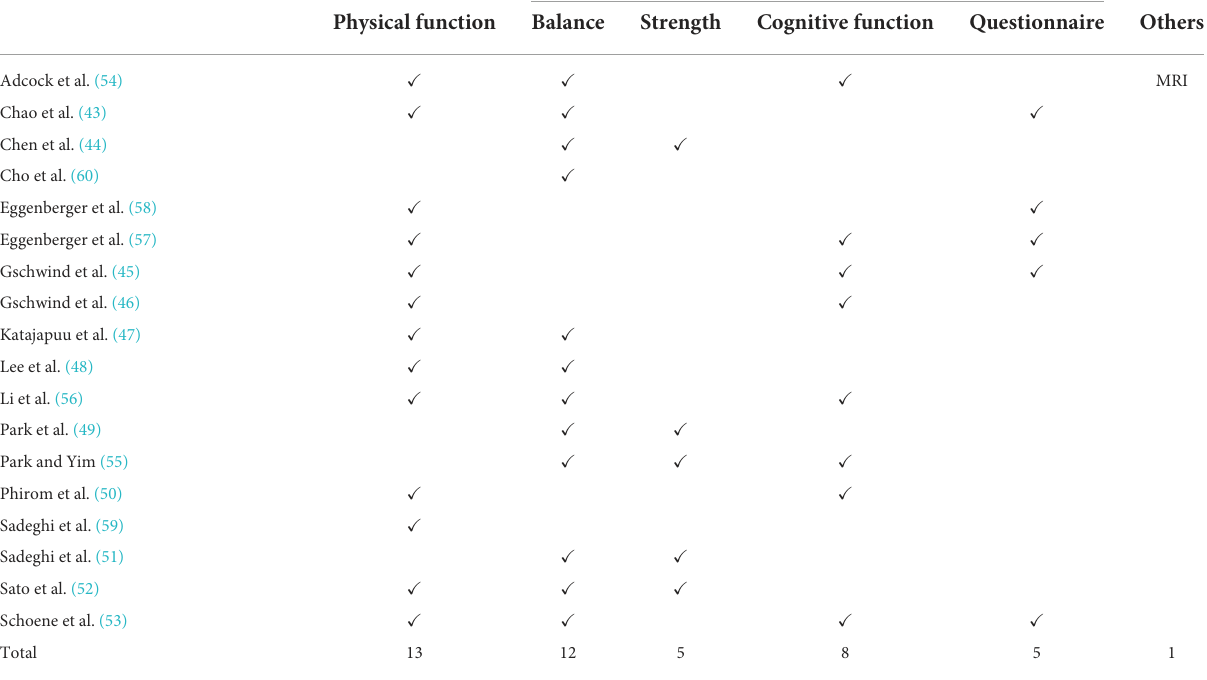
TABLE 1 Outcome